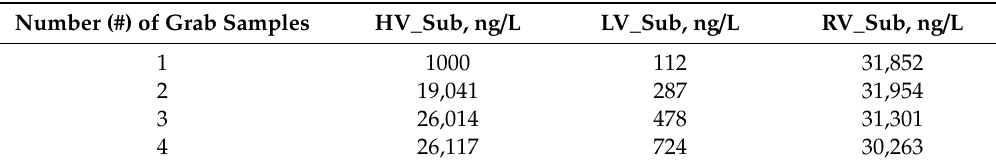
Table 4. Average concentrations of the three substances in the case of grab samples (with the di ff erent number of samples collected).